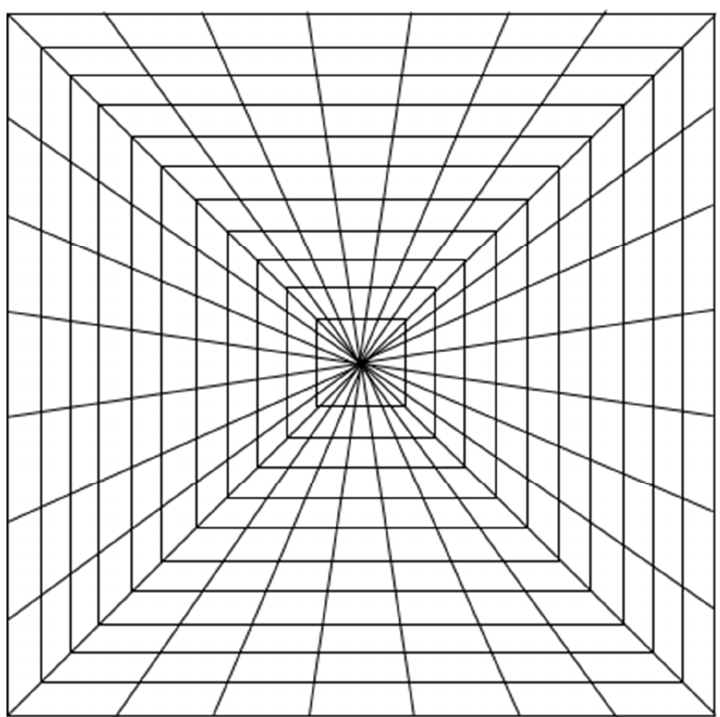
Figure 2. Schematic of experimental stimulus 2 (CN): COMPLETE (obliques + squares) EQUIDISTANT “NO PERSPECTIVE” GRID.